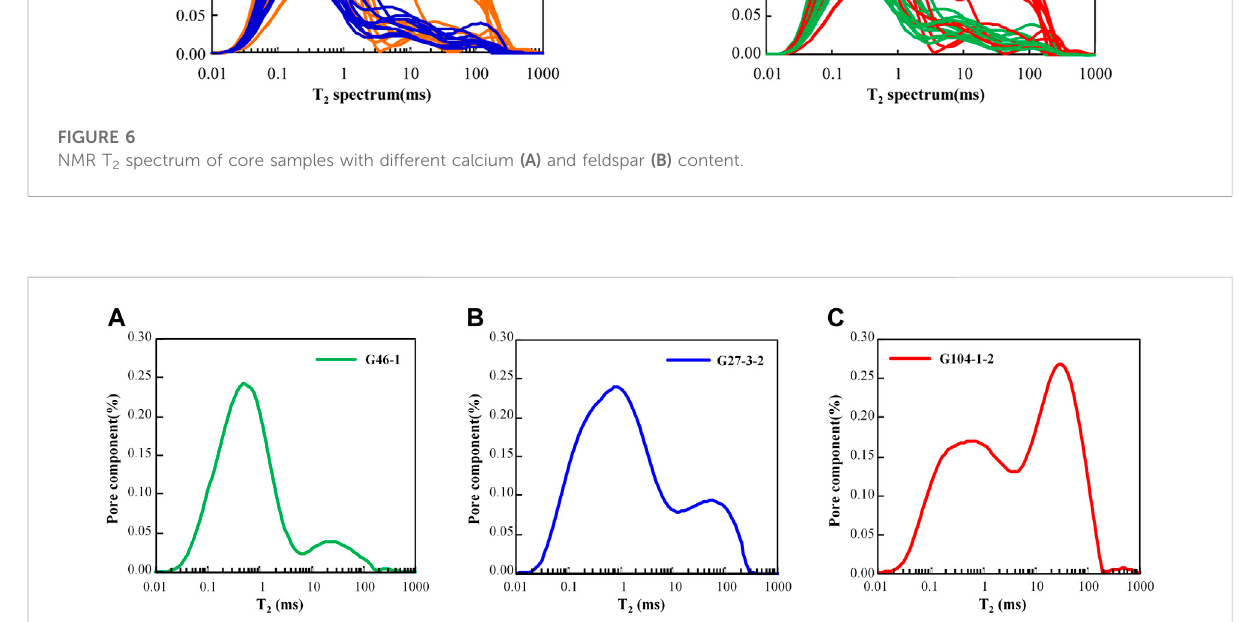
FIGURE 7 NMR T 2 spectrum of core with different development degrees of dissolution pores. (A) No.G46-1, low calcium content (0.76%), high feldspar content (46%), undeveloped dissolution pores (secondary surface porosity = 1.5%), poor pore structure. (B) No.G27-3-2, low calcium content (1.39%), high feldspar content (42.8%), dissolution pores developed (secondary areal porosity 3.5%), better pore structure. (C) No.G104-1-2, low calcium (0.76%), high feldspar content (46%), dissolution pores developed (secondary areal porosity 3.8%), good pore